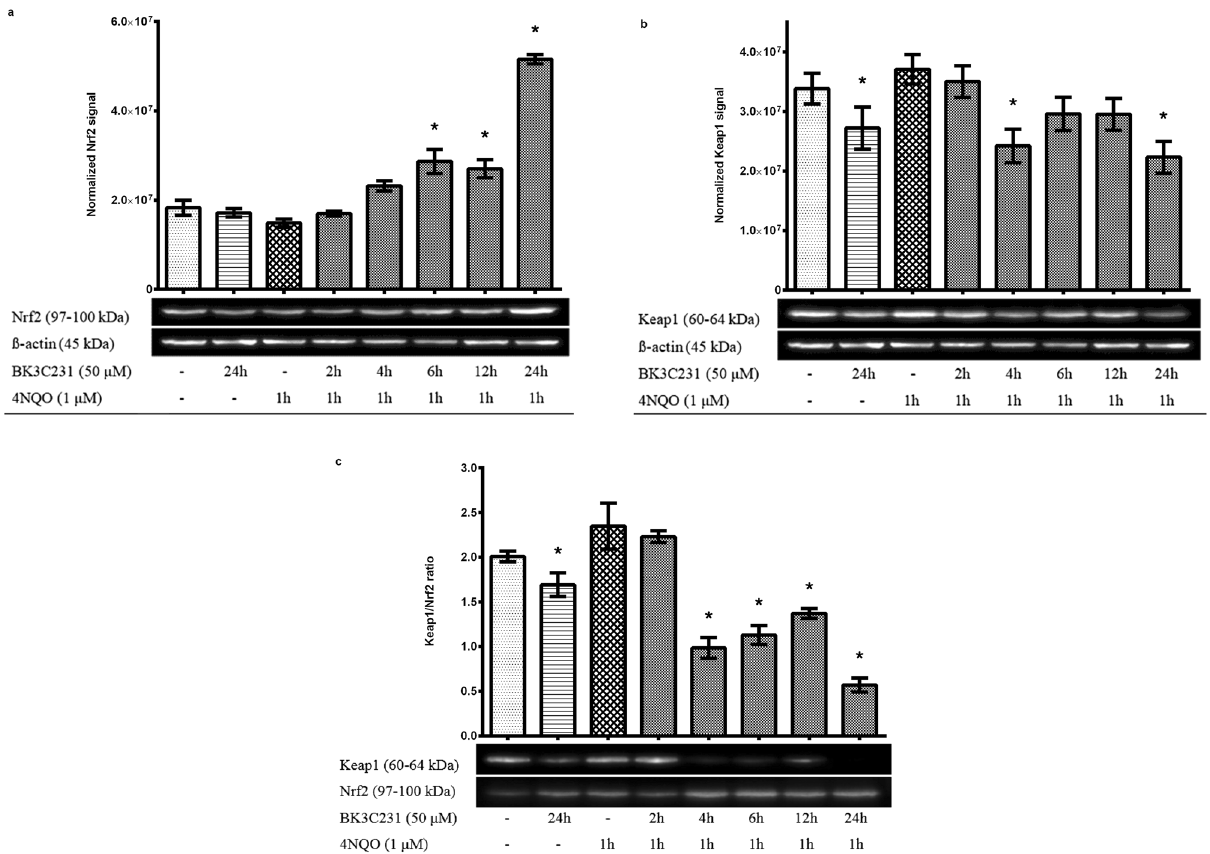
Figure 3. Effect of BK3C231 pretreatment on Nrf2 ( a ) and Keap1 ( b ) protein expression levels and dissociation level of Nrf2 from Keap1 ( c ). ( a , b ) Constitutive expressions of Nrf2 and Keap1 at the basal level were observed in untreated control cells. 4NQO reduced Nrf2 expression and increased Keap1 expression over untreated control. Cells treated only with BK3C231 showed a significant reduction of Keap1 expression over 4NQO- treated cells whereas Nrf2 expression remained at basal level. BK3C231 pretreatment for 6 h, 12 h, and 24 h significantly increased Nrf2 expression over 4NQO-treated cells. Keap1 expression was significantly reduced in cells pretreated with BK3C231 at 4 h and 24 as compared to that of 4NQO-treated cells. ( c ) The Keap1/ Nrf2 ratio was increased in 4NQO-treated cells over untreated control. BK3C231 pretreatment from as early as 4 h till 24 h significantly reduced Keap1/Nrf2 ratio over 4NQO-treated cells and untreated control, thereby inducing dissociation of Nrf2 and Keap1 leading to Nrf2 activation. Treated whole cell lysates were subjected to immunoblotting analysis to determine the expression level of Nrf2 and Keap1. Treated whole cell lysates were subjected to co-immunoprecipitation as mentioned in “Results” and immunoblotting analysis to determine the Keap1 to Nrf2 ratio. Each data point was expressed as mean ± SEM from at least three independent experimental replicates. *p < 0.05 against 4NQO 1 h. The blots displayed in the figure are cropped. Full-length blots are presented in Supplementary Fig.